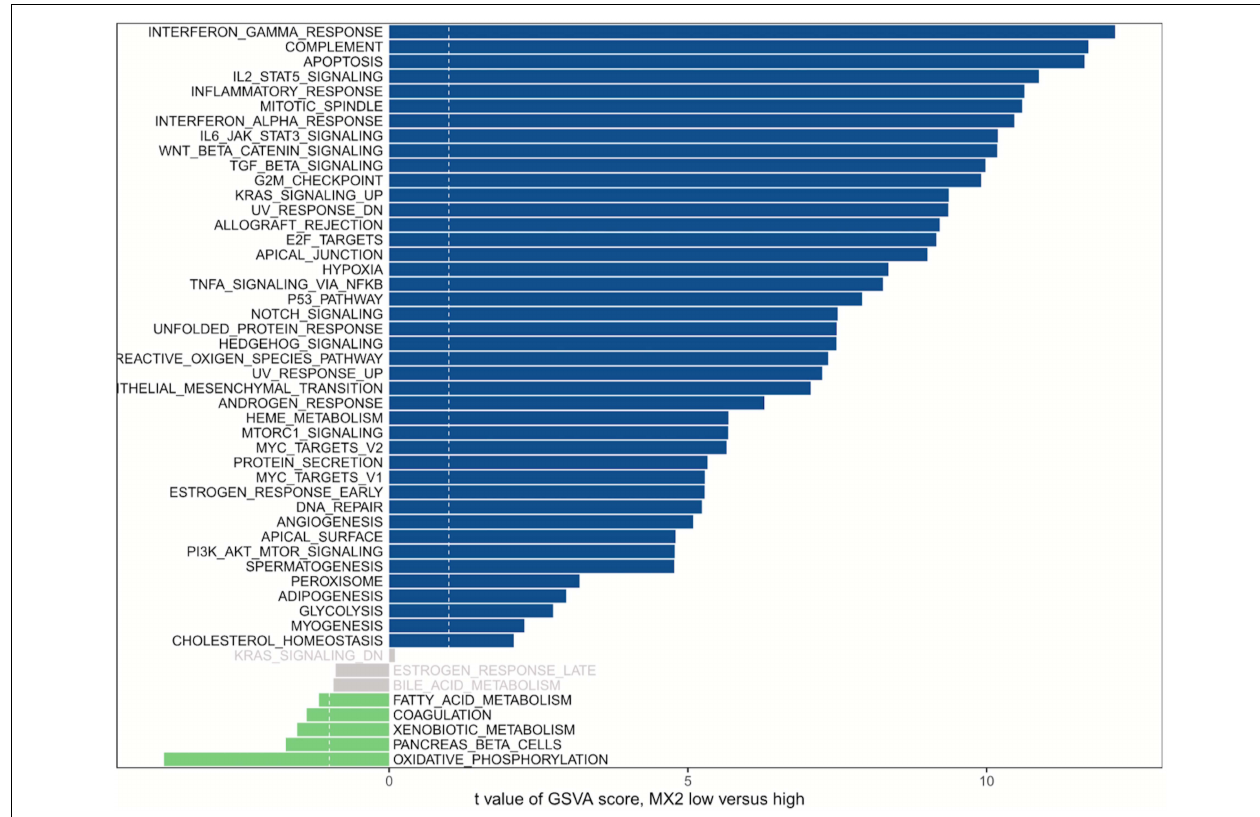
FIGURE 6 | GSVA of MX2. MX2 is involved in certain pathways contributing to antiangiogenic therapy resistance. Blue bars represent high MX2 expression, and green bars represent low MX2 expression. GSVA, Gene Set Variation